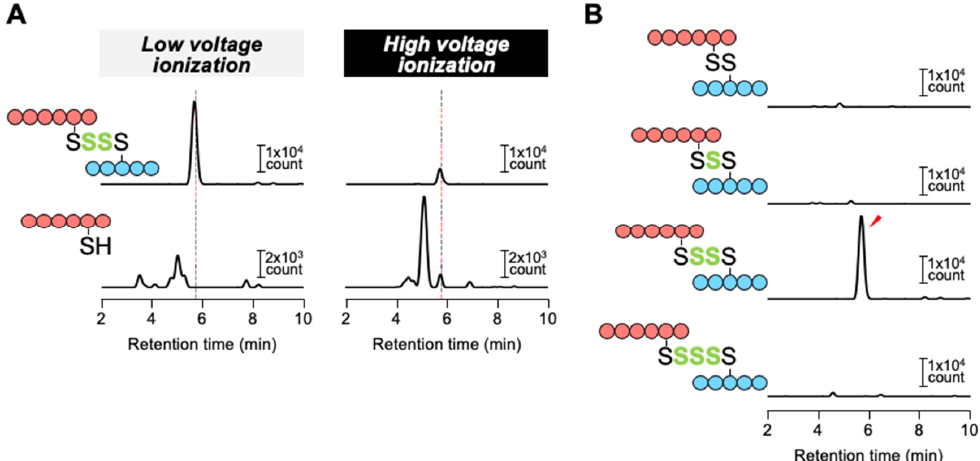
Figure 7. Detection of oxidized polysulfur structure of Na 2 S ‐ treated YgaV by iCOPS method: ( A ) The complex of ILC 31 ML (blue) and KNVYC 98 P (red) with an intra ‐ tetrasulfide bridge was detected under low voltage ionization conditions (30 V), while the oxidized polysulfur bond was disrupted by high voltage ionization (60 V), resulting in the formation of free KNVYC 98 P peptide which was detected at the same retention time as the intact peptide complex (dashed line); ( B ) Various lengths of oxidized polysulfur bridges between ILC 31 ML and KNVYC 98 P peptides were investigated under low ‐ voltage ionization conditions (30 V). A significant signal of the intra ‐ tetrasulfide bridge ‐ con ‐ taining complex was only detected (red arrow).